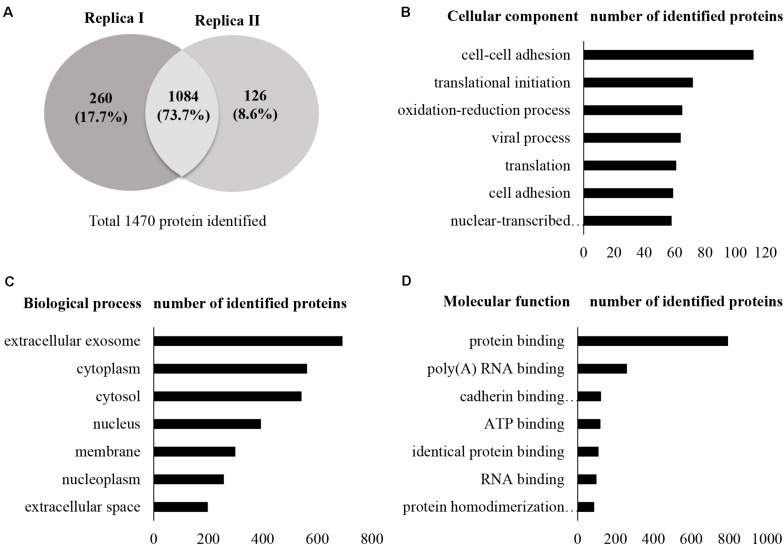
Secretome profile and functional clustering of human SCs. (A) Venn diagram summarizing the overlap in protein identification between two independent proteomic analyzes of SC-CM, which identified 1,344 (replica I) and 1,210 (replica II) proteins, respectively. Additional details are listed in Supplementary Tables S2–S4. (B–D) DAVID bioinformatics resource was used to analyze the secretome of SCs in order to identify enriched biological terms in the common secreted proteins extracted from the MS analysis. (B) GO enrichment analysis of cellular components. Proteins localized in extracellular exosomes were highly enriched. (C) GO enrichment analysis of biological processes. Highly enriched SC secreted proteins are involved in cell–cell adhesion. (D) GO enrichment analysis of molecular function. Highly enriched SC secreted proteins are involved in protein binding. Only the top seven cellular components, biological processes, and molecular functions have been shown here for vertical sizing. Additional details are listed in Supplementary Tables S5–S7. SC-CM, Schwann cell–conditioned media; GO, Gene Ontology; DAVID, Database for Annotation, Visualization, and Integrated Discovery.